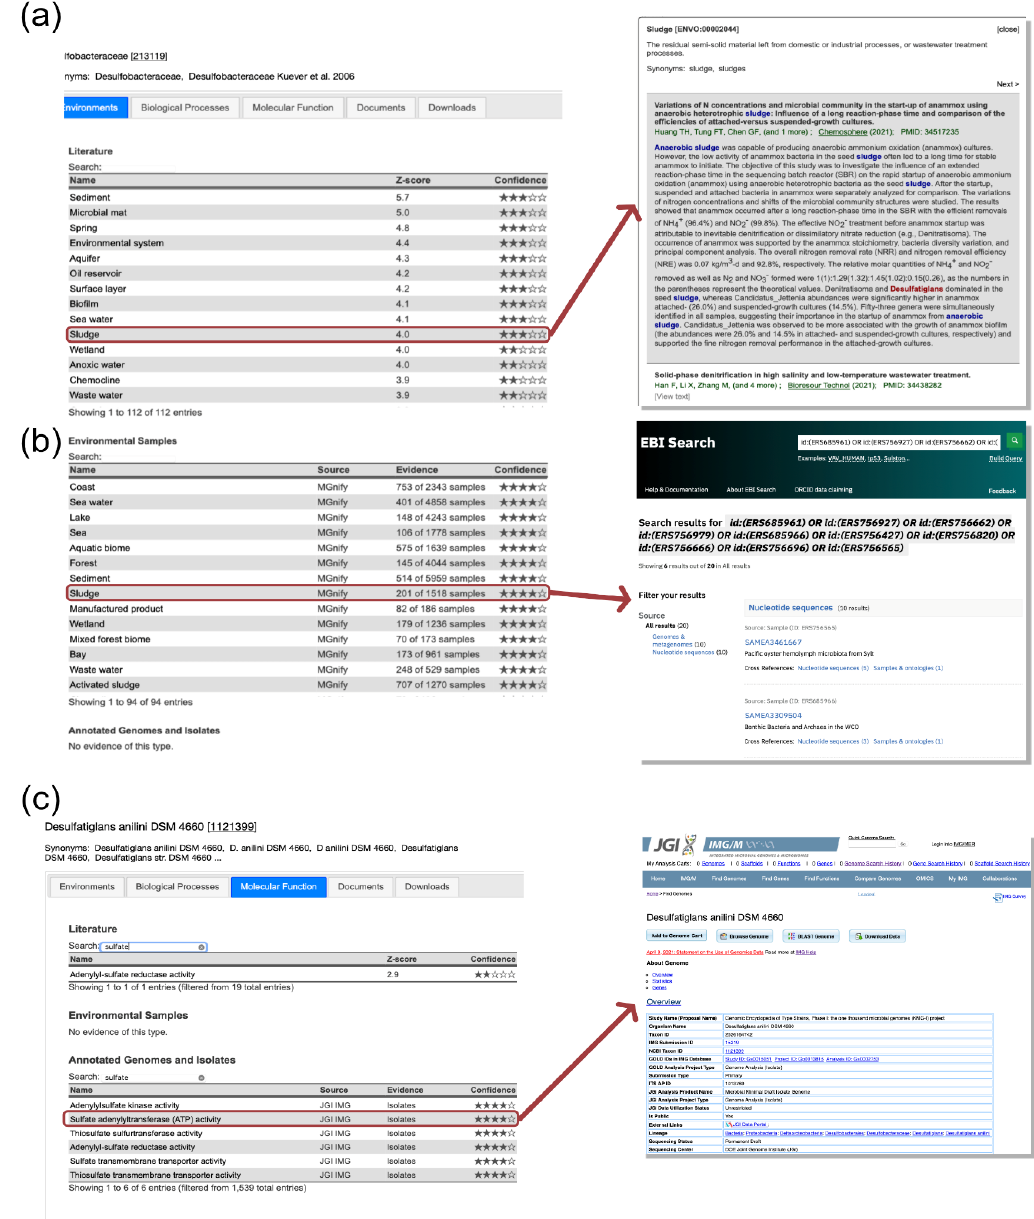
Figure 3. Each association is supported by original data: ( a ) Literature channel has a pop-up function- ality that displays the scientific articles that support each specific association. The associated entities are highlighted in color. ( b ) Environmental Samples channel redirects to the samples that support the specific association (currently MGnify has this functionality). ( c ) Annotated Genomes and Isolates channel similarly redirects to the isolates ids that each association is based on (both Struo and JGI IMG are